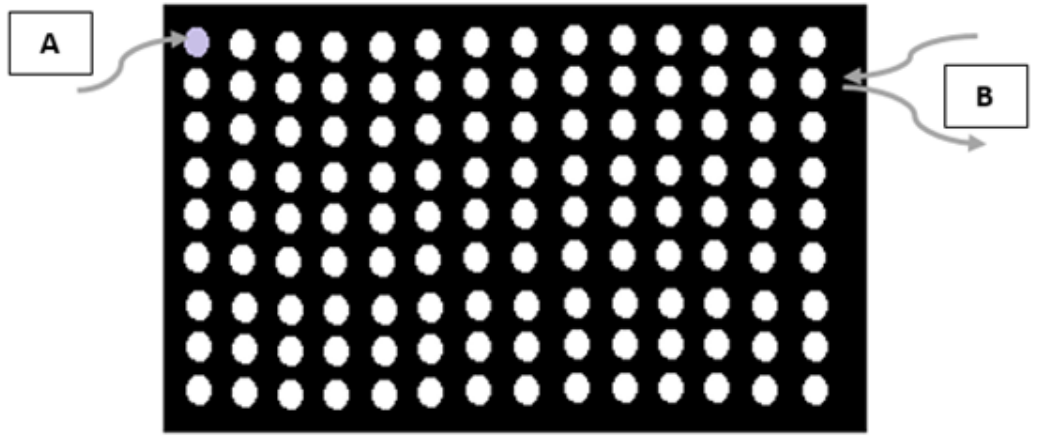
Figure 5. Five different types of the current collector with ( a ) 41%; ( b ) 39.4%; ( c ) 38.5%; ( d ) 27%; ( e ) 16% open ratios. Adapted with permission from [46], copyright 2015.